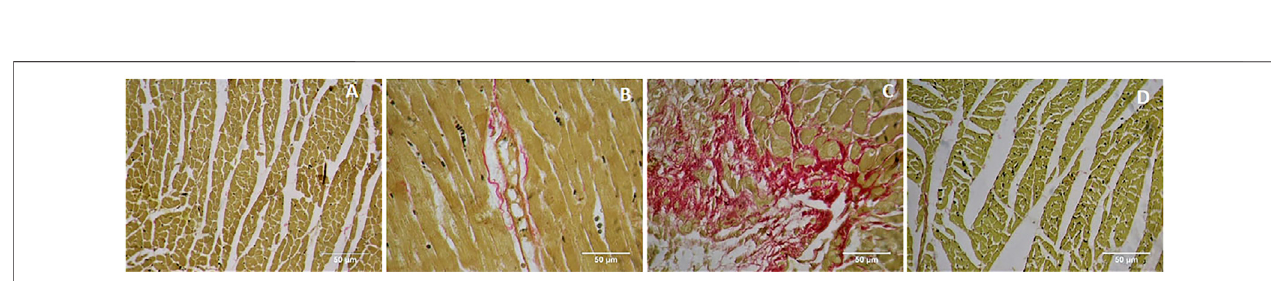
FIGURE 8 | Histopathology of heart tissue stained with Masson ’ s trichrome (40 × ). (A) Control rat shows a normal distribution of collagen. (B) GA alone treated rat shows a normal distribution of collagen. (C) ISO-control rat shows interstitial collagen accumulation (blue colour). (D) Pretreatment with GA showed reduced interstitial collagen accumulation.